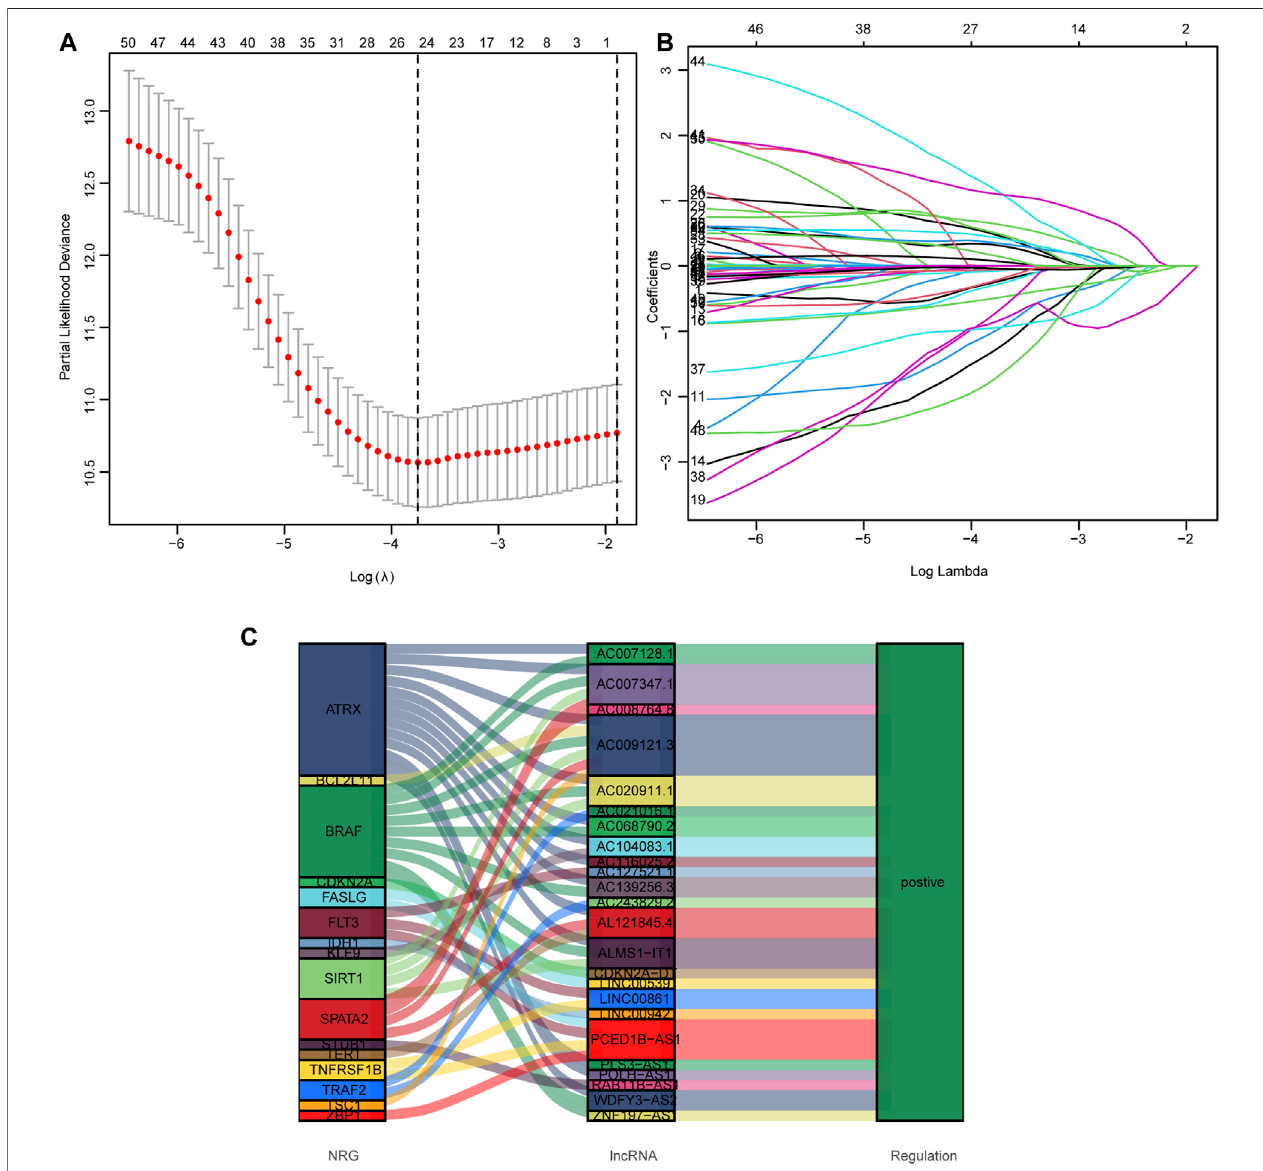
FIGURE 3| Construction of prognostic signature in HNSCC. (A) LASSOwith 10-fold cross-validation. (B) Coef fi cient pro fi le plots. (C) The Sankey diagram shows the connection degree between the 24 prognostic lncRNAs and the necroptosis-related genes.